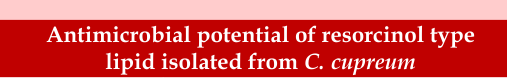
Antimicrobial potential of resorcinol type lipid isolated from C. cupreum